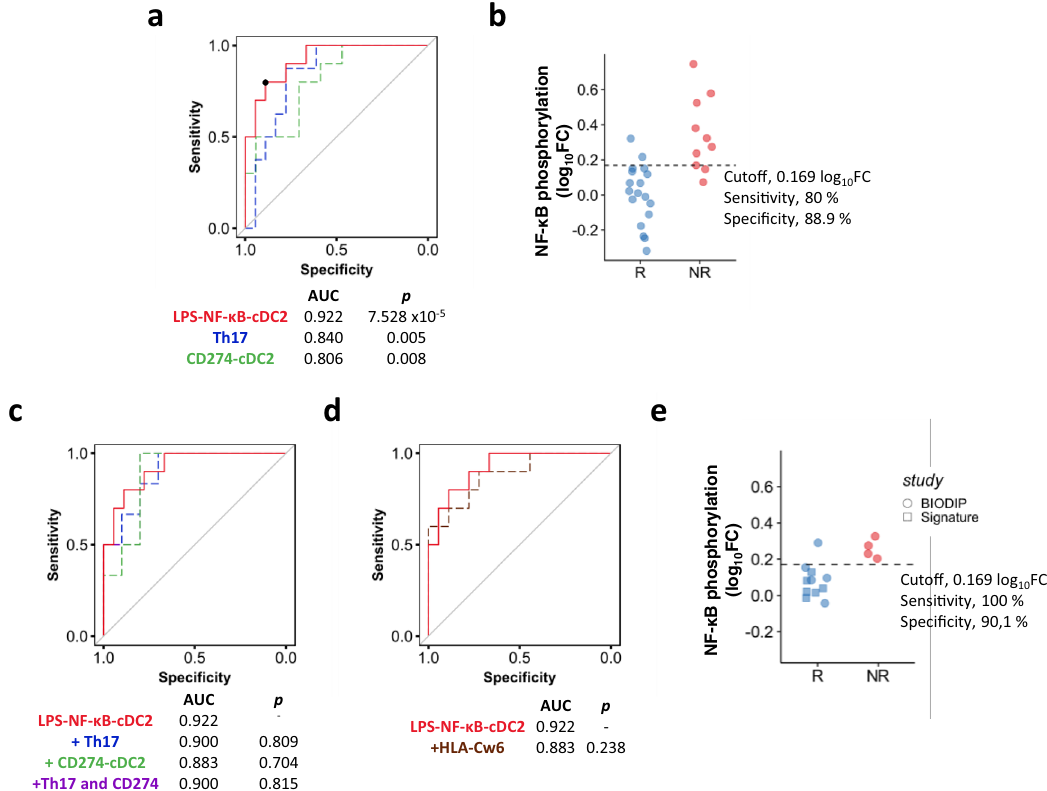
Fig. 6 NF- κ B phosphorylation in cDC2 at baseline as biomarker of response to adalimumab. a Receiver operator characteristic (ROC) of linear models for LPS-induced NF- κ B phosphorylation in cDC2 at baseline (w0, red line), frequency of blood Th17 cells at baseline (w0, blue line) and PDL1 expression in cDC2 at w1 (green line) predicting PASI75 outcome in adalimumab patients at week 12 (combined cohort, n = 26 – 28). Black dot shows the cut-off for maximal accuracy for the best ROC curve. p values vs an AUC of 0.5 are shown on the graph. b Dot plot graph of the PSORT adalimumab combined cohort ( n = 28) classi fi ed in PASI75 responder (R, blue, n = 18) and non-responders (NR, red, n = 10) according to the cut-off for LPS-induced NF- κ B phosphorylation in cDC2 at w0. c ROC of LPS-induced NF- κ B phosphorylation in cDC2 at w0 (solid red line) and combination biomarkers (LPS-NF-kB- cDC2 + Th17, dotted blue line; LPS-NF-kB-cDC2 + CD274-cDC2 dotted green line, and LPS-NF-kB-cDC2 + Th17 + CD274-DC2, dotted purple line). The purple line partially overlaps with the blue line. p values vs AUC of LPS-NF-kB-cDC2 are shown. d ROC analysis for LPS-NF-kB-cDC2 predicting PASI75 outcome in adalimumab patients (solid red line) and when combined with HLA-C*06:02 genotype (dotted brown). p value vs AUC of LPS-NF-kB-cDC2 is shown. e ROC clinical validation using optimal cut-off for LPS-induced NF- κ B phosphorylation in cDC2 at w0 identi fi ed in the PSORT combined cohort to classify an independent cohort of adalimumab patients in PASI75 responders (blue, n = 11) and non-responders (red, n = 4) (clinical validation cohort). Two-tailed Mann – Whitney U test, ( a , c , d ). Source data are provided as a Source Data fi